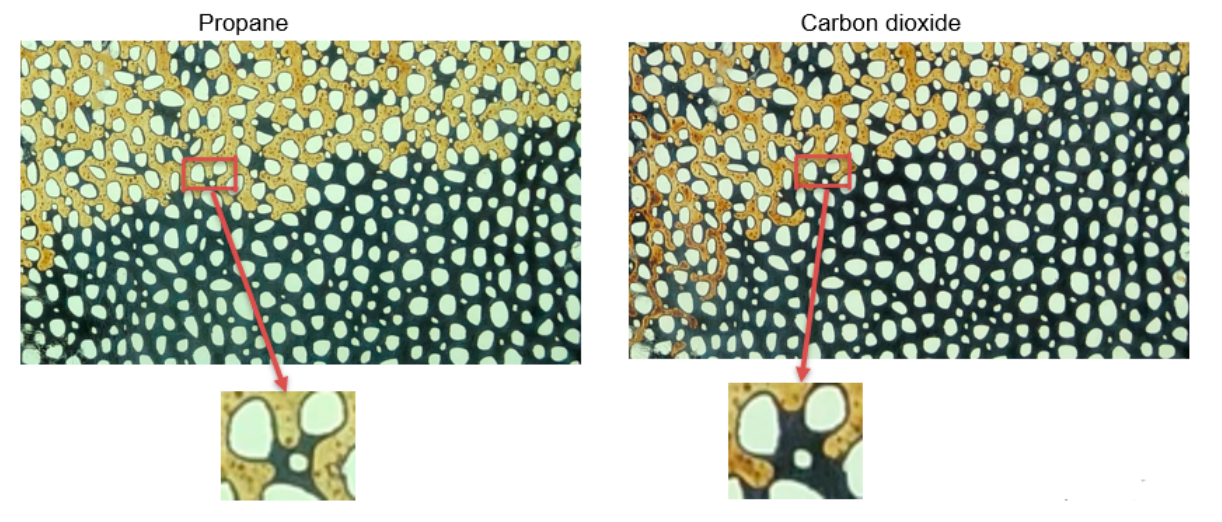
Figure 20. Solvent performance comparison between propane and carbon dioxide in the same reservoir pattern.